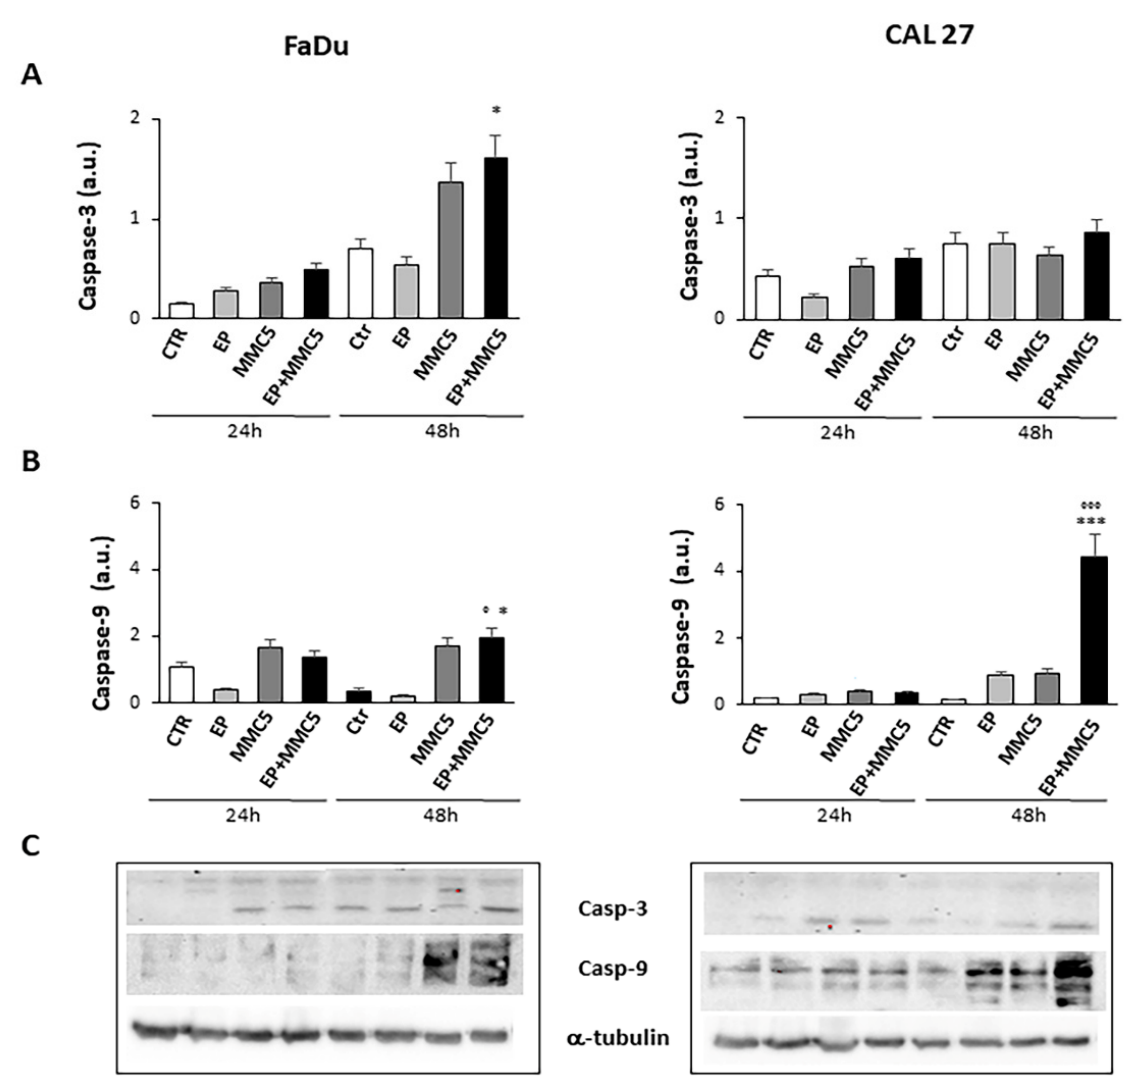
Figure 10. Caspase expression. The bar graphs show the relative quantification of caspase-3 ( A ) and caspase-9 ( B ) densitometry in the FaDu (left panel) and in the CAL 27 cells (right panel). Each protein is normalized to α -tubulin. Data are expressed as the mean ± SD of three independent experiments. * p ≤ 0.05 vs. control; ◦ p ≤ 0.05 compared to MMC. *** p < 0.001 vs. control; ◦◦◦ p ≤ 0.001 compared to MMC. ( C ) Representative Western blot analysis of caspase-3 and -9 in FaDu (left panel) and CAL 27 cells (right panel). The α -tubulin determination was used as load control. Not-cropped Western blot figures are available in Figure